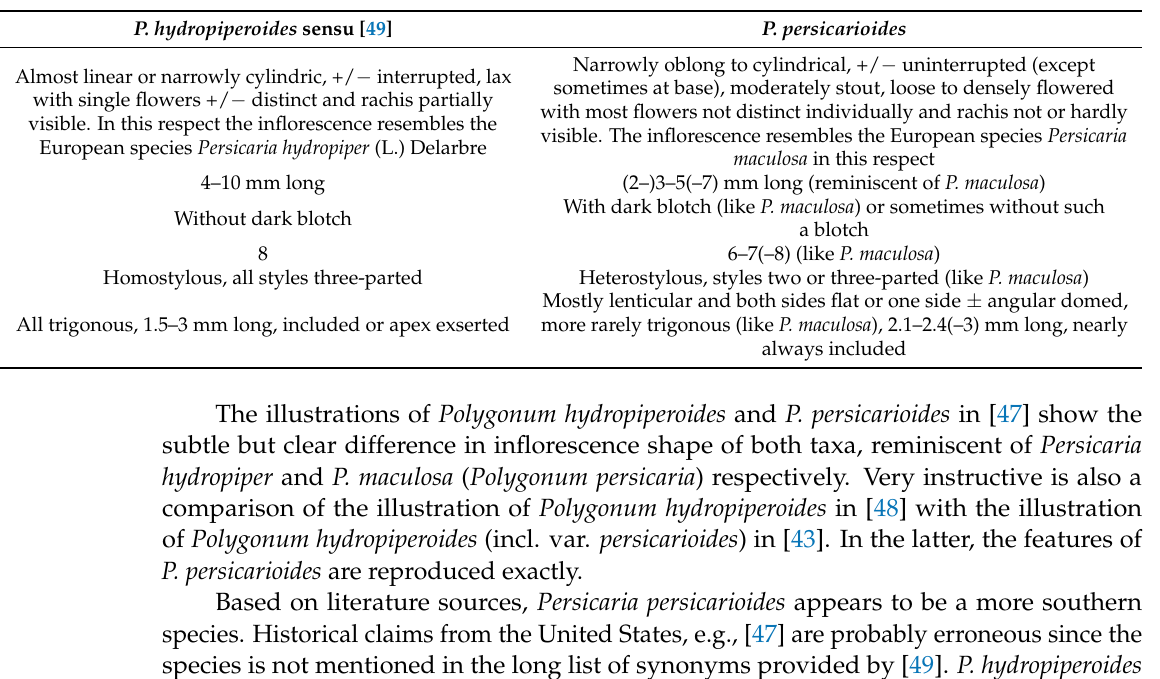
Table 1. Main differences between P. hydropiperoides and P. persicarioides , based on data extracted from, among oth- ers, [42,47–49] and own